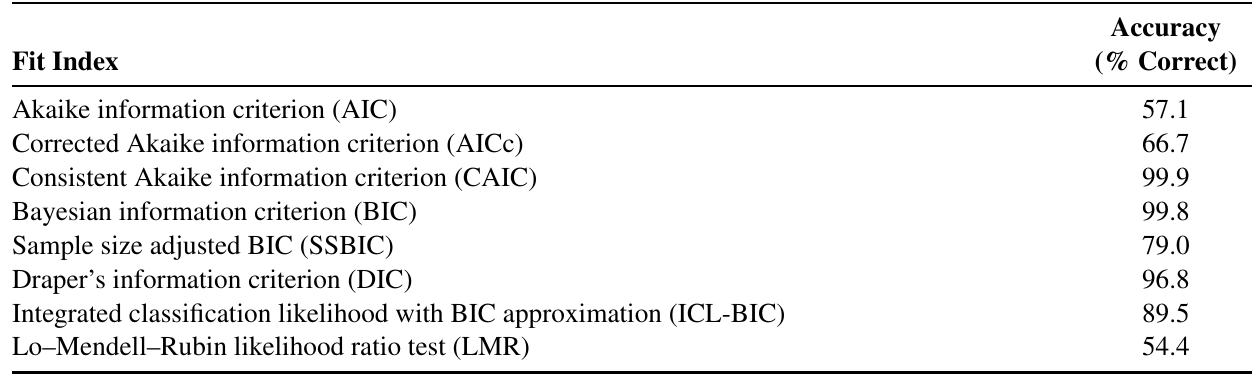
Table 4. Overall model selection accuracy rates across all